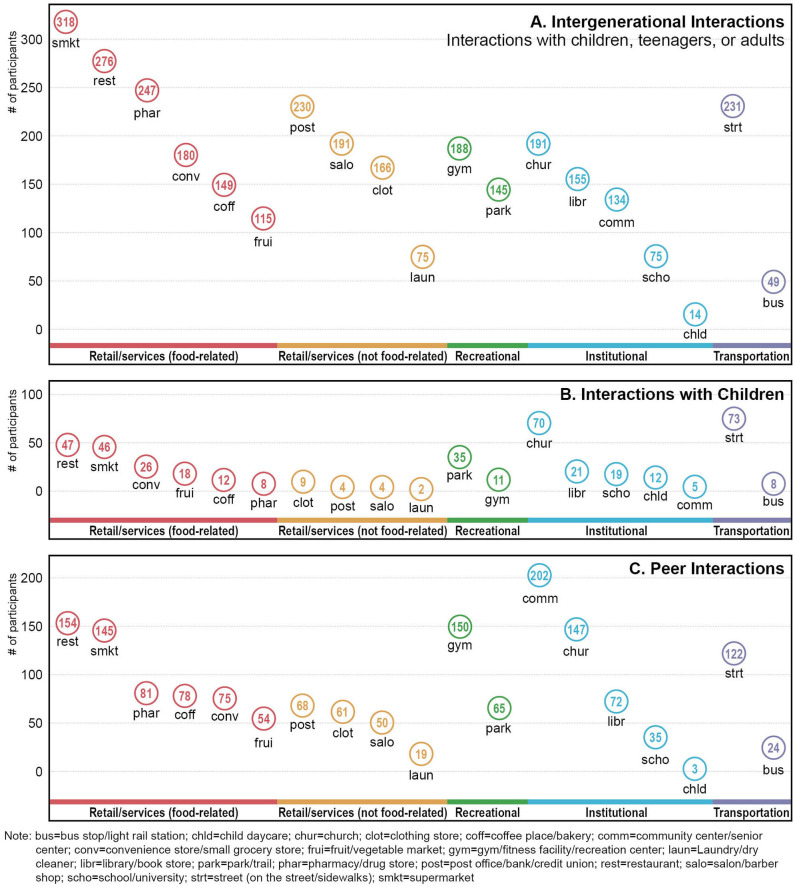
Places for intergenerational and peer interactions at least once a week.